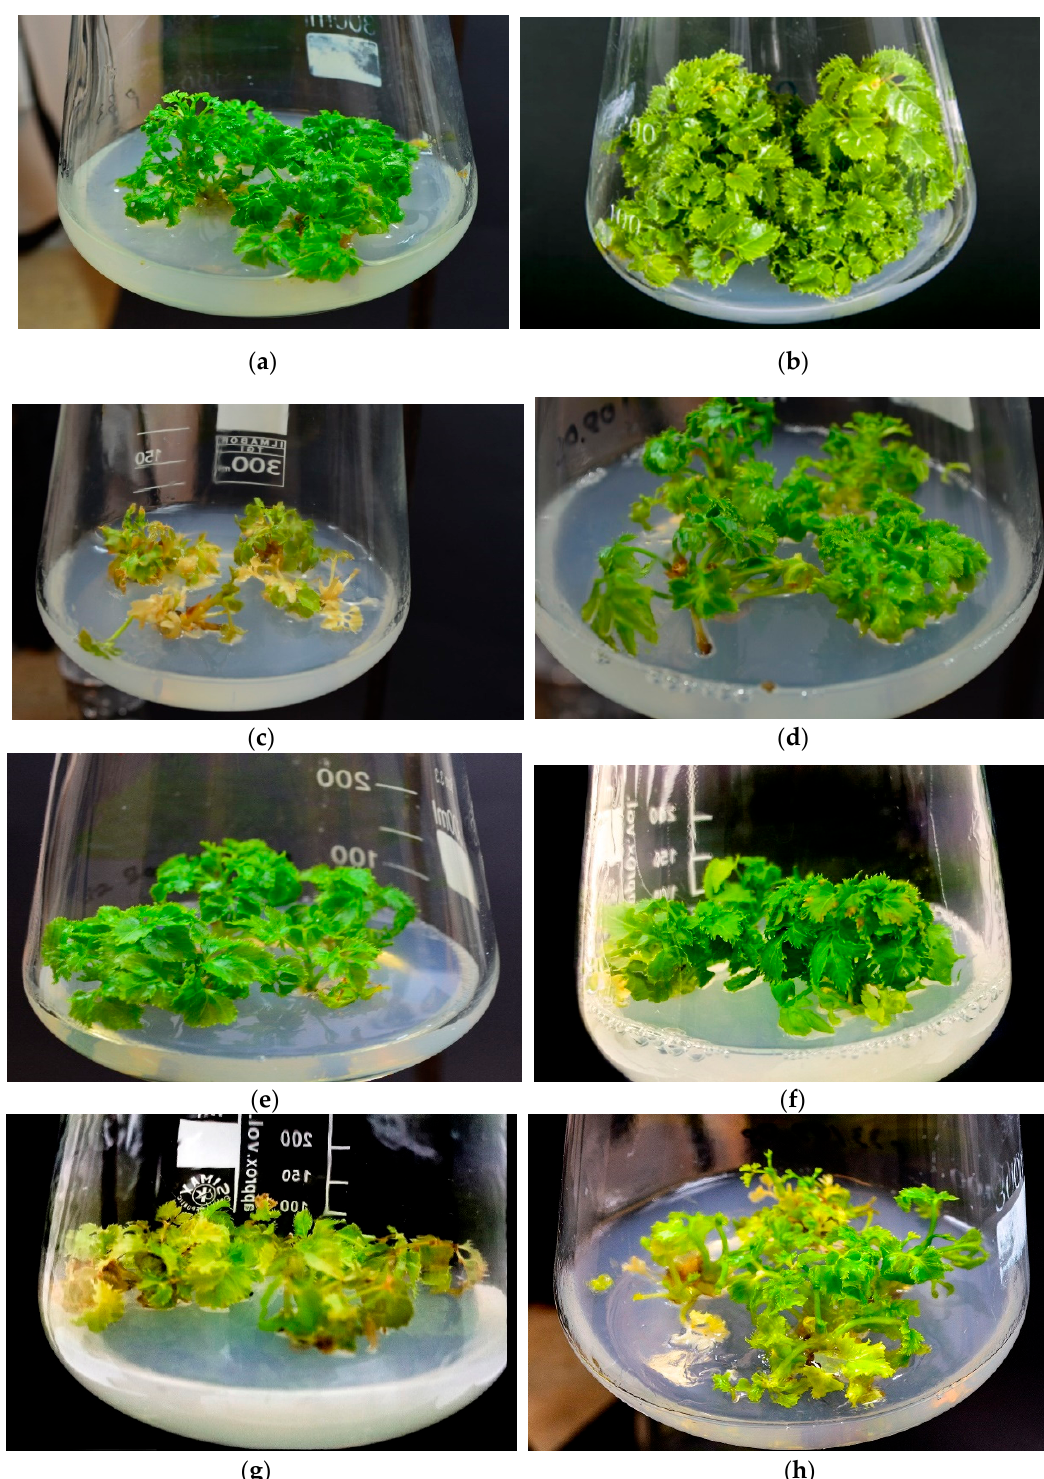
Figure 1. Morphology of Polyscias filicifolia shoots growing on LS medium supplemented with 8.88 µM BAP and 2.32 µM KIN for 4 weeks and then transferred to the fresh medium and cultivated for one week: ( a ) control cultures (untreated); cultures supplemented with elicitor/s and/or alarmone: ( b ) 50 µM SA; ( c ) 200 µM MeJA; ( d ) 50 µM SA + 200 µM MeJA; ( e ) 5 µM Ap3A; ( f ) 5 µM Ap3A + 50 µM SA; ( g ) 5 µM Ap3A + 200 µM MeJA; ( h ) 5 µM Ap3A + 50 µM SA + 200 µM MeJA.